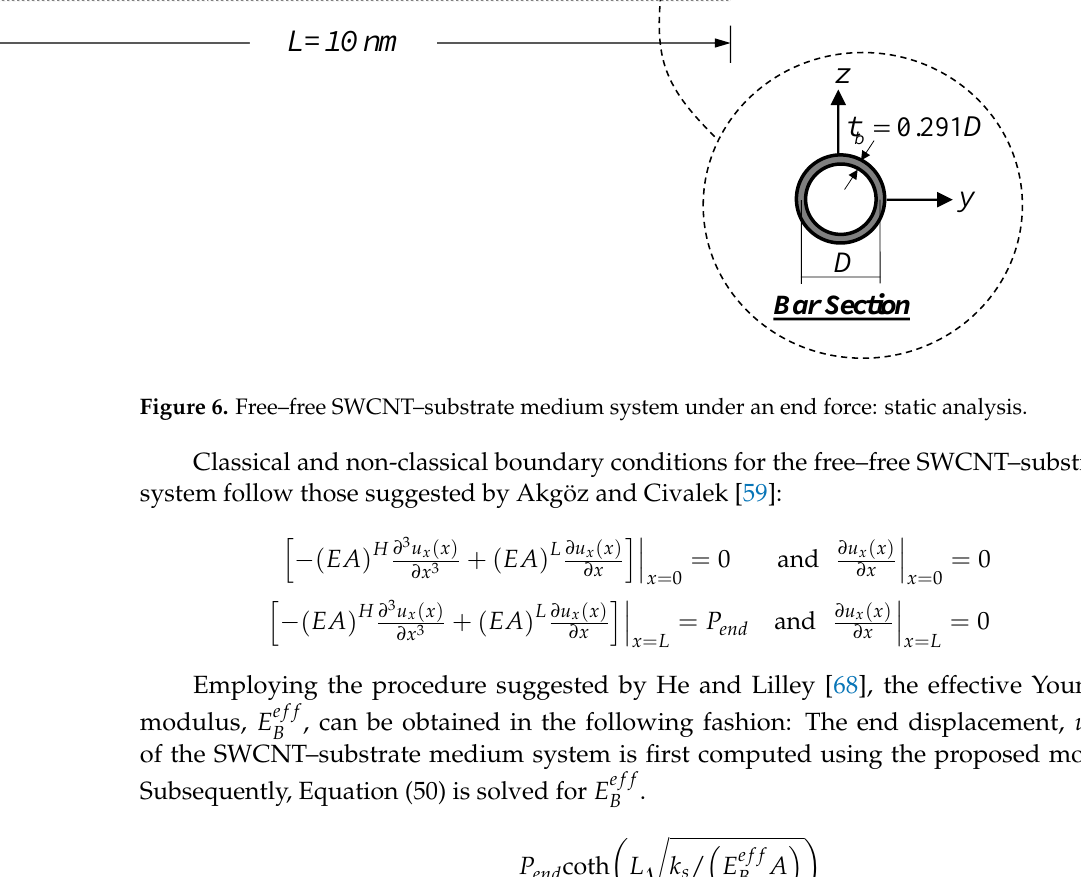
It is noted that the right-hand side of Equation (50) defines the end displacement analytically obtained from the local bar–substrate medium